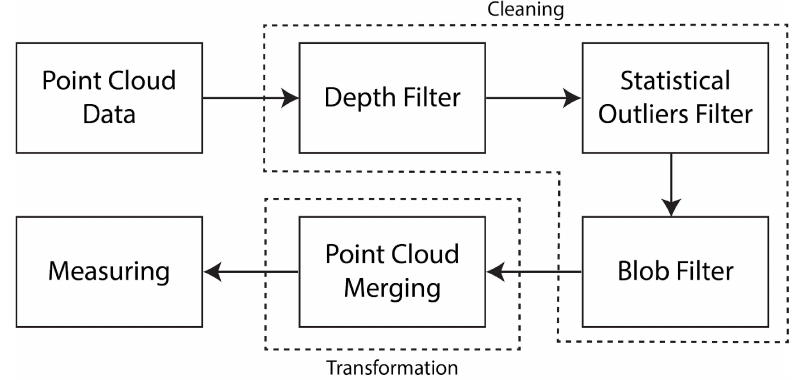
Fig. 1 Flow of proposed